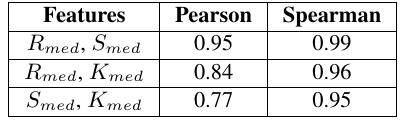
Table 2: Correlation between roundness-based